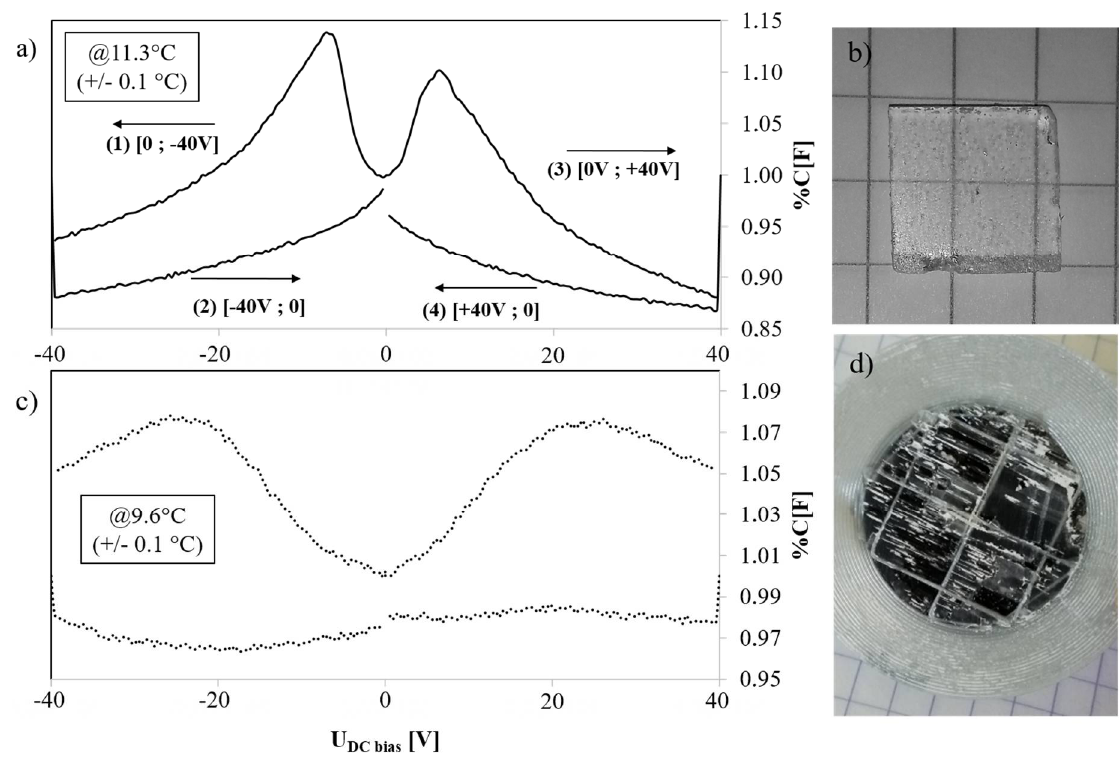
Figure 3. Normalized capacitance hysteresis loop measured on ( a , b ) thin RS square single crystal and ( c , d ) on RS/PLA thin sample, with bias voltage applied from −40 V to +40 V.